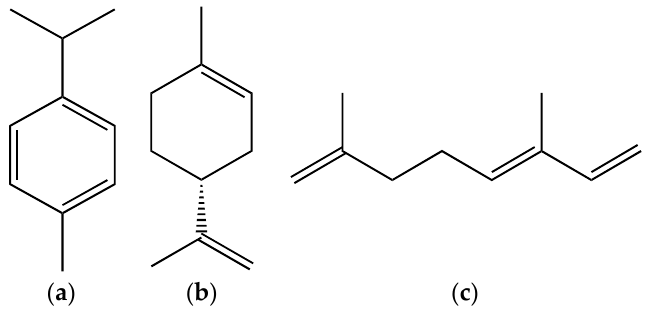
Figure 2. Major compounds of the essential oils (EOs) of Berberis vulgaris leaves and flowers. ( a ) p -cymene; ( b ) limonene; ( c ) ocimene. ( a ) p -cymene; ( b ) limonene; ( c )